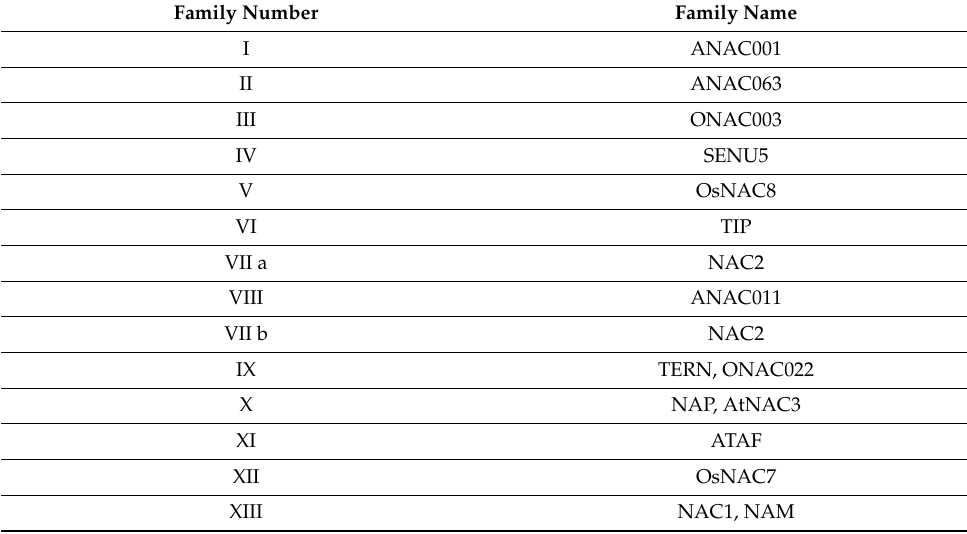
Figure 1. Phylogenetic analysis of the NAC transcription factors of kiwifruit and Arabidopsis . Table 1. Subfamily classification